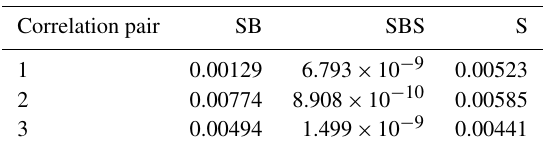
Table B1. Minimum deviatoric strain as displayed in Figs. 11, 10 and 9.